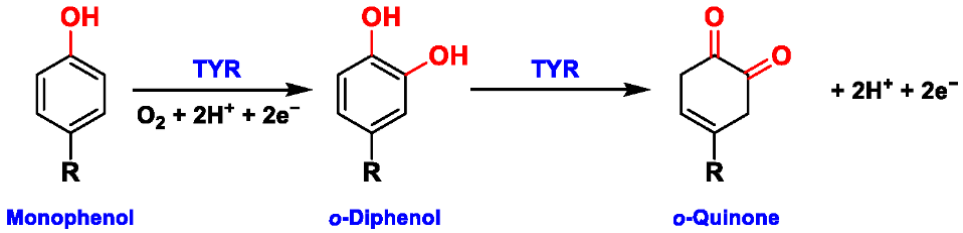
Figure 1. The slow ortho -hydroxylation of monophenol and the fast oxidation of catechol catalyzed by TYR.